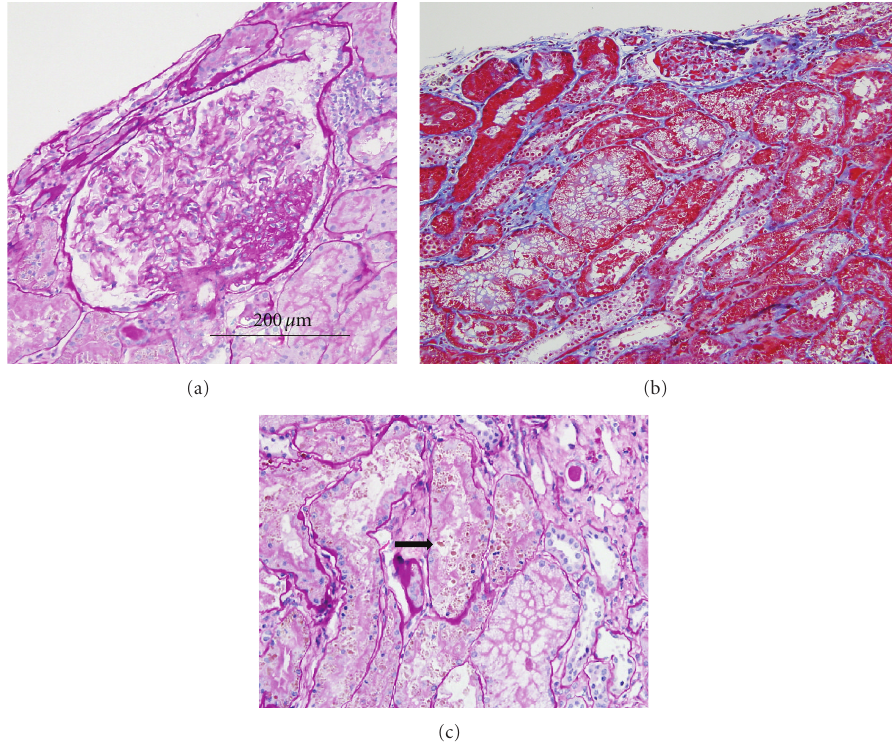
Figure 1: (a) Perihilar segmental sclerosis (PAS, original magnification 20x). (b) Di ff use tubulopathy: variably size tubular profiles, hypertrophic tubular epithelial cells, cytoplasmic vacuolization, and coarse fuchsinophilic cytoplasmic accumulations (trichrome, original magnification 20x). (c) Di ff use tubulopathy: tubular epithelial cell cytoplasmic irregular waxy brown-yellow ceroid-lipofuscin—like pigment accumulations (black arrow) (PAS, original magnification 40x).